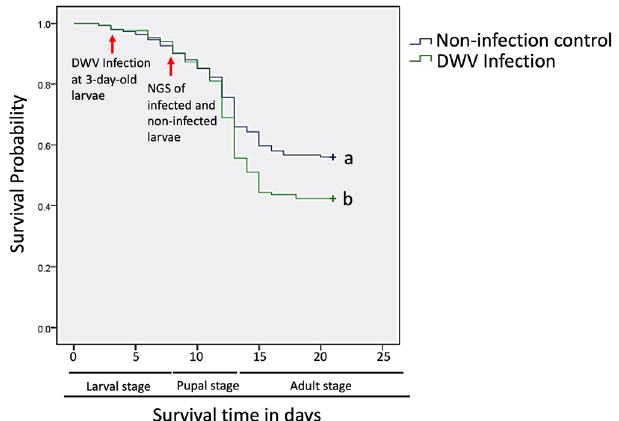
Figure 1. A survival curve was constructed based on Kaplan–Meier analysis using the data of the deformed wing virus (DWV) infection (1.55 × 10 10 copies/per larva) and noninfection control groups over 22 days (100 larvae/per repeat and total 3 replicates). A significant difference between these groups was observed during all stages in this experiment. Different letters are significantly different (chi-square = 9.785; 1 d.f.; P =